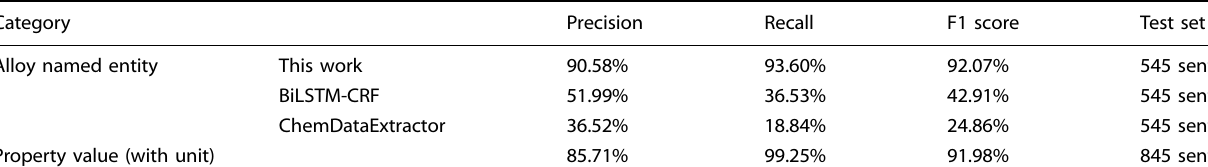
Table 2. Precision, recall, and F1 score of the NER. Category Precision